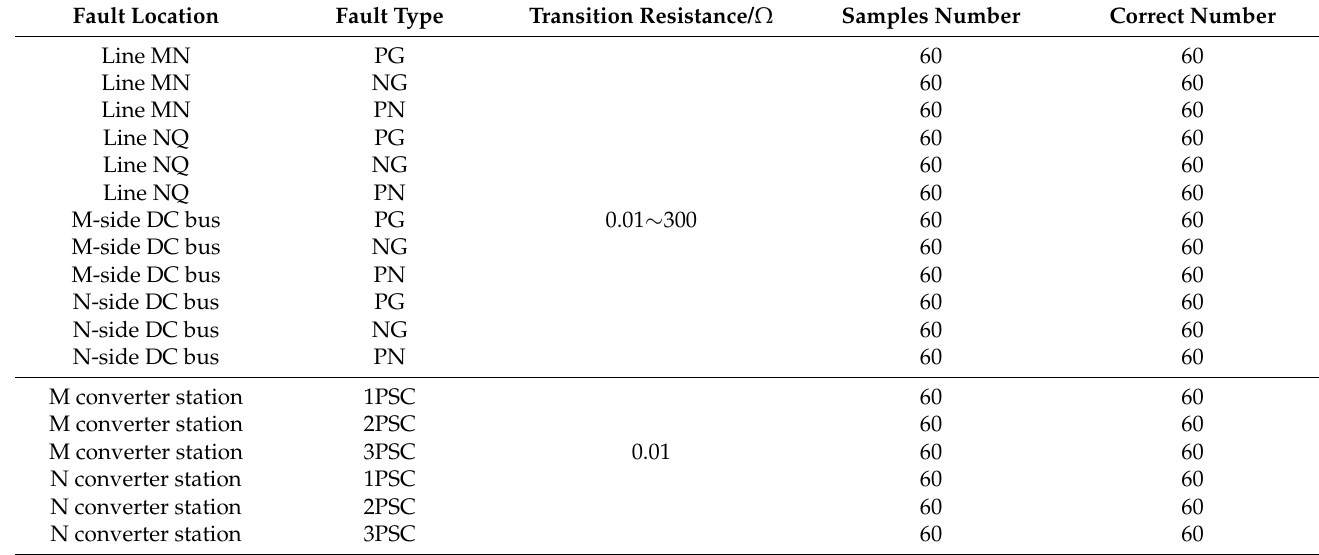
Table 5. Test results of fault classification and location.